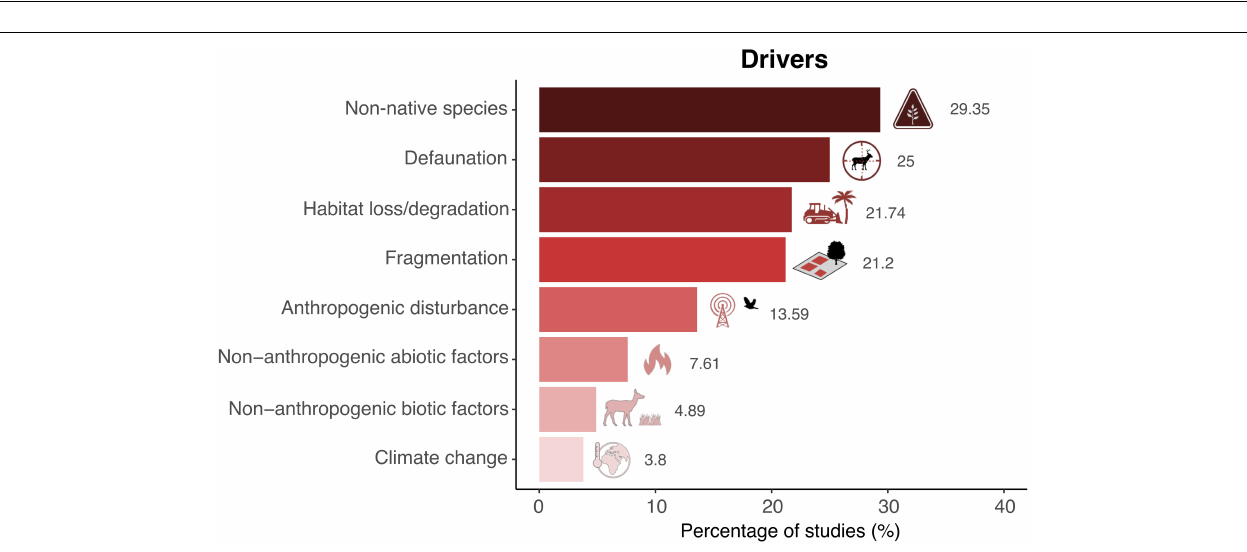
FIGURE 1 | The global extent of seed dispersal disruptions. (A) Map of the study locations, with each point representing an individual case ( N = 186 realms identified in 184 articles). (B) Bar chart representing the percentage of studies addressing seed dispersal disruptions in each of the biogeographical regions.